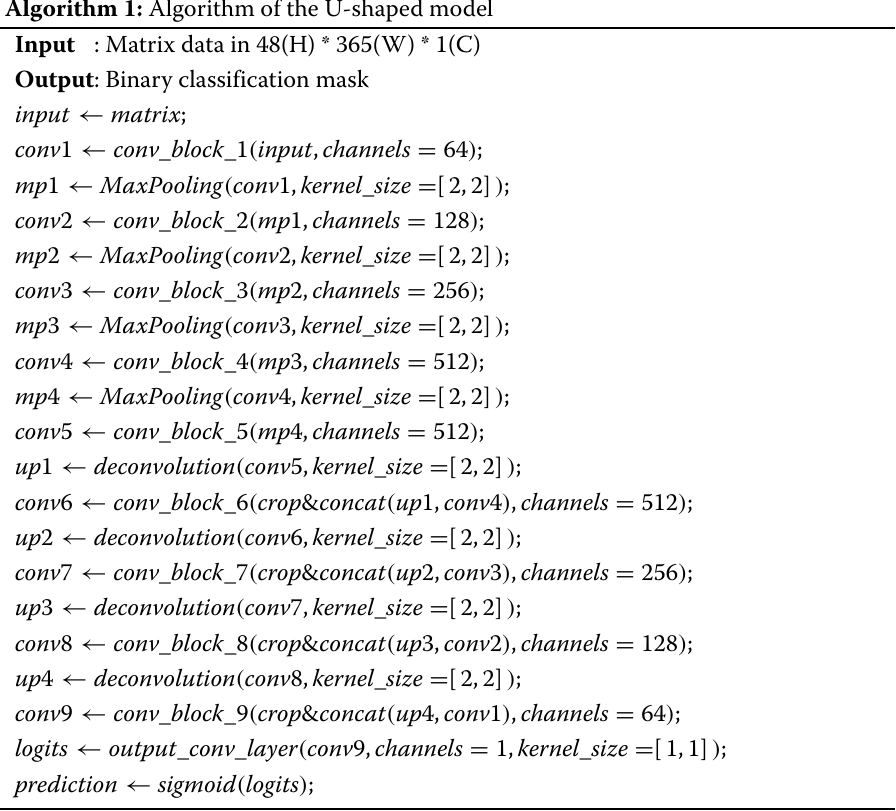
Algorithm 1: Algorithm of the U-shaped